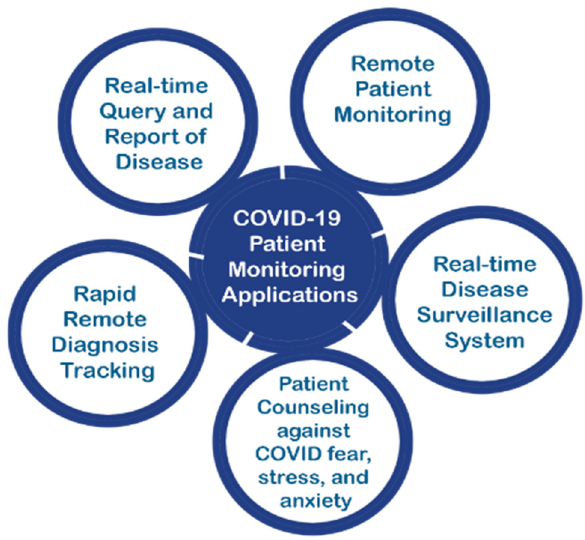
Figure 6. Proposed framework for COVID-19 patients’ remote monitoring.